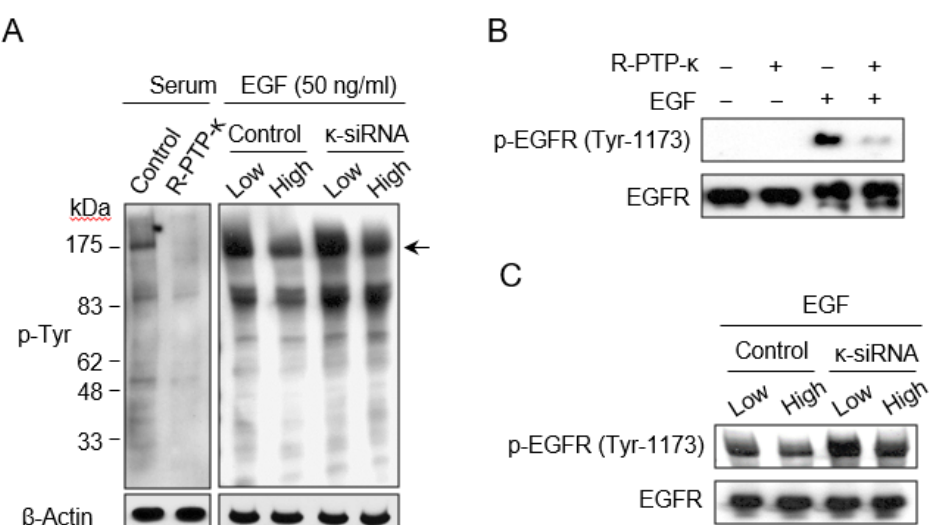
Figure 2. The status of global protein tyrosine phosphorylation status in relation to cell density and R-PTP- κ expression level. ( A ) Effect of R-PTP- κ on the regulation of EGFR phosphorylation. Serum-starved HeLa cells were stimulated with 10% FBS (left panel) or 50 ng/mL of EGF (right panel) for 10 min, and the cell lysates were analyzed using immunoblotting with anti-p-Tyr antibody. β -Actin was used as the loading control. Arrow indicates the position of 170-kD band. ( B ) Regulation of EGF-induced tyrosine phosphorylation of EGFR by R-PTP- κ overexpression. ( C ) Regulation of EGF-induced tyrosine phosphorylation of EGFR by R-PTP- κ knock-down. EGF-induced tyrosine phosphorylation of EGFR was analyzed using Western blotting with anti-p-EGFR (Tyr-1173) antibody. Total EGFR was used as the loading control.